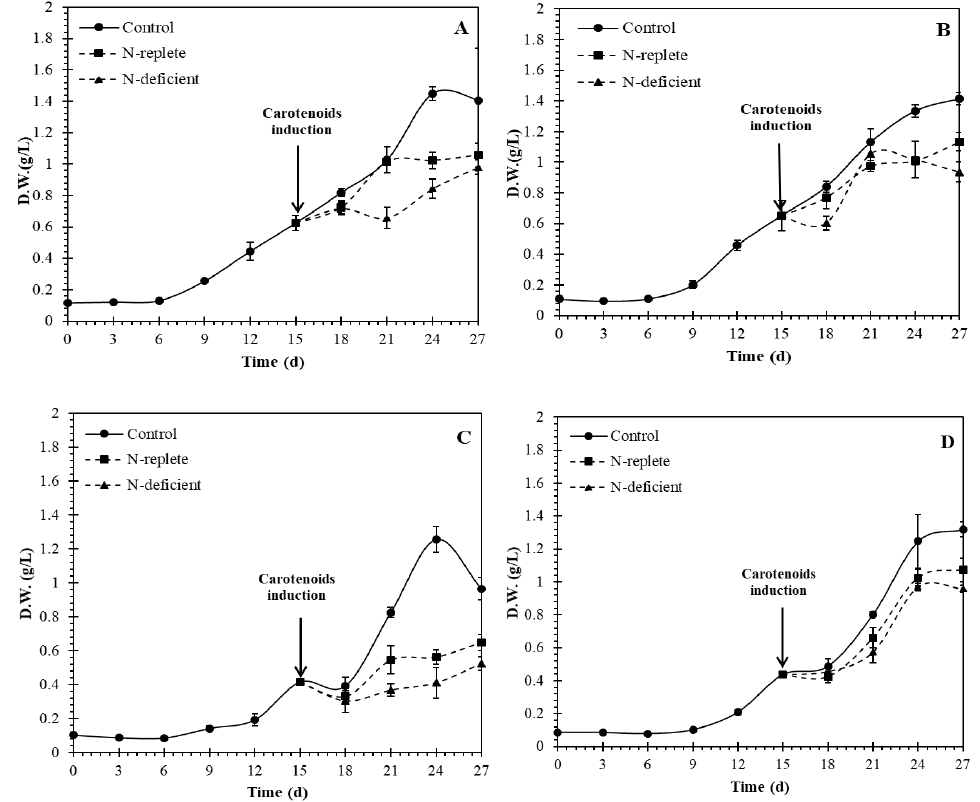
Figure 5. Growth curves (dry weight in g/L) of Coelastrella sp. cultured on BG-11 medium modified with different nitrogen and phosphorus concentration combinations (A: N+P-, B: N-P+, C: N-P-, D: N+ P+) for 15 days and then further cultured for 12 days using three different strategies to induce carotenogenesis: control, N-replete and N-deficient. Cultures were maintained in a mixed state by bubbling with a mixture of 3% CO 2 in N 2 .